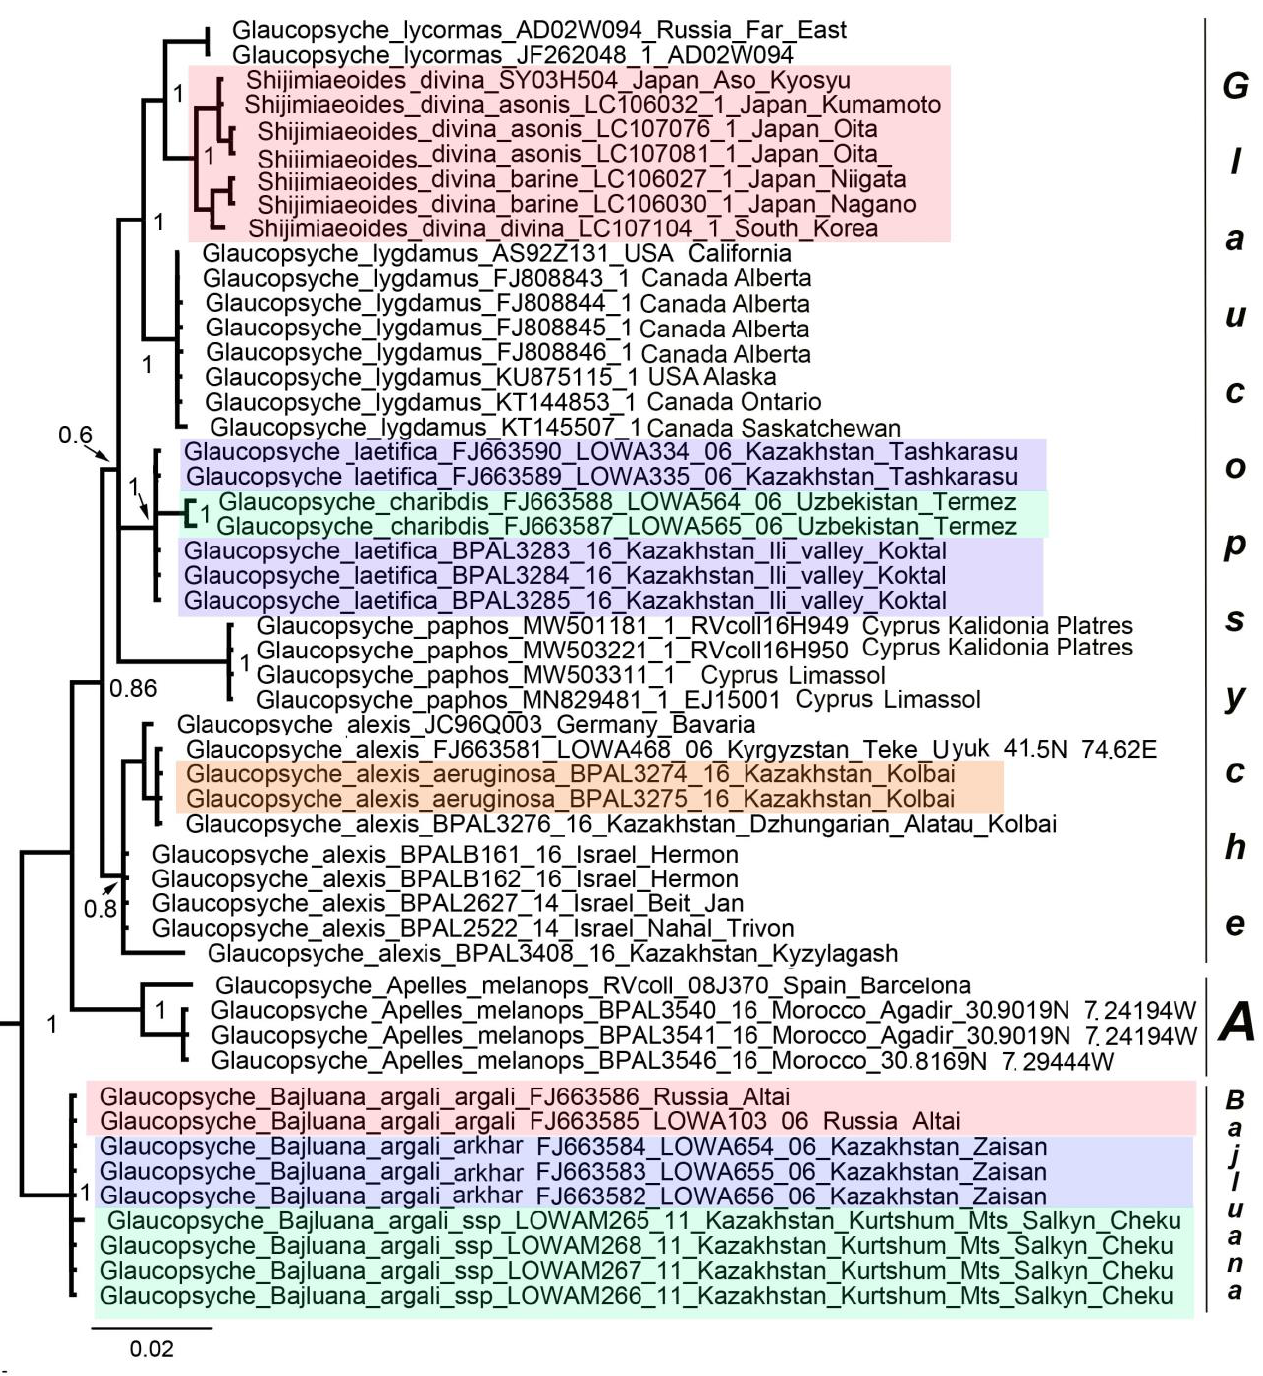
Figure 5. Fragment of the concatenated ( 28S + H3 + EF1-a + wingless + ITS2 + COI + COII ) BI tree. The genus Glaucopsyche is shown. A is the subgenus Apelles . Posterior probabilities are indicated at the nodes.